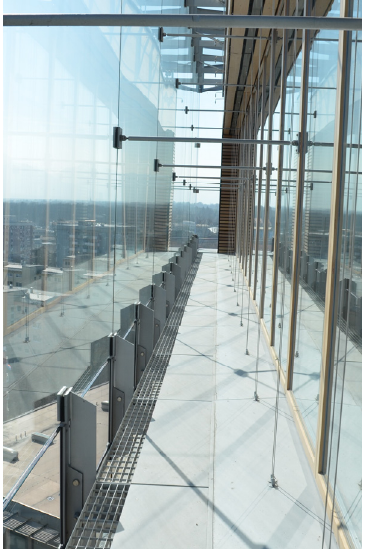
Figure 6. Transsolar Double Skin Façade—Sparkasse Rosenheim, Reprinted with Permission from © Transsolar.